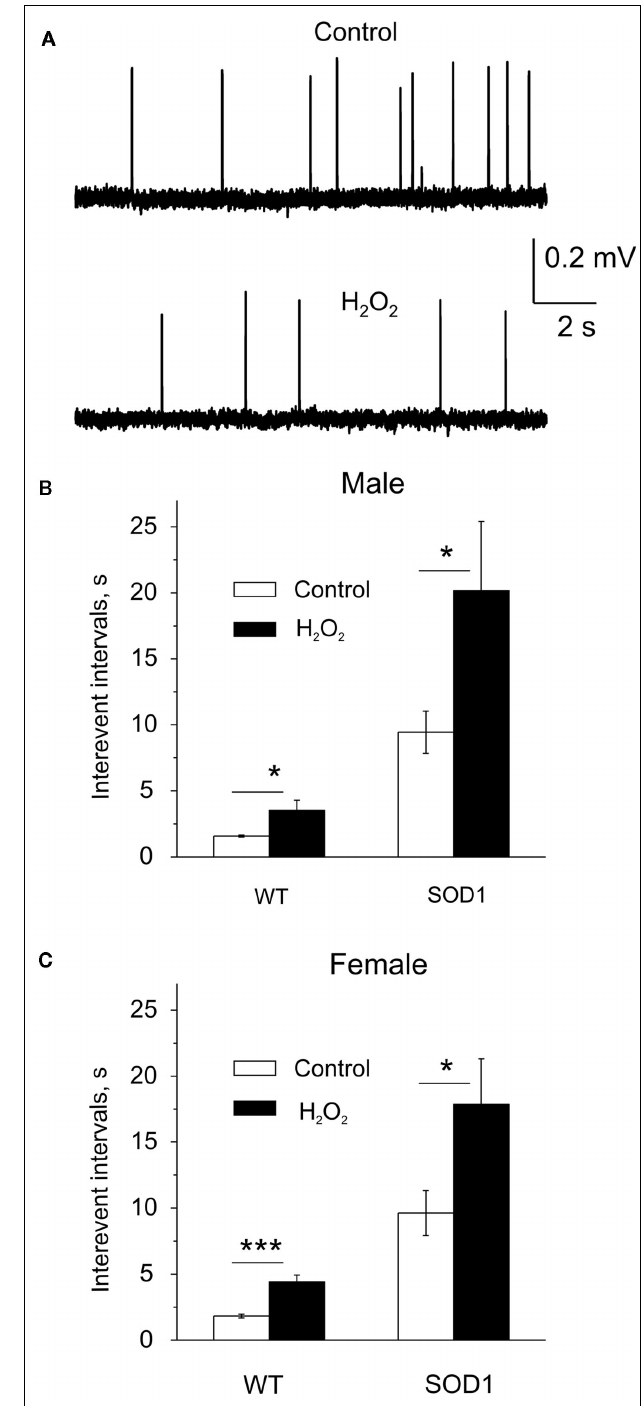
FIGURE 6 | Reactive oxygen species-induced depression of quantal release by exogenous H 2 O 2 . (A) Examples of MEPPs in theWT mice before (control) and after application of 300 μ M H 2 O 2 . (B,C) Histograms showing the mean interevent intervals of MEPPs before (control) and after application of 300 μ M H 2 O 2 to the neuromuscular junction in male (B) and female mice (C) . Note greater depression in G93A-SOD1 males. * = P < 0.05, *** = P <